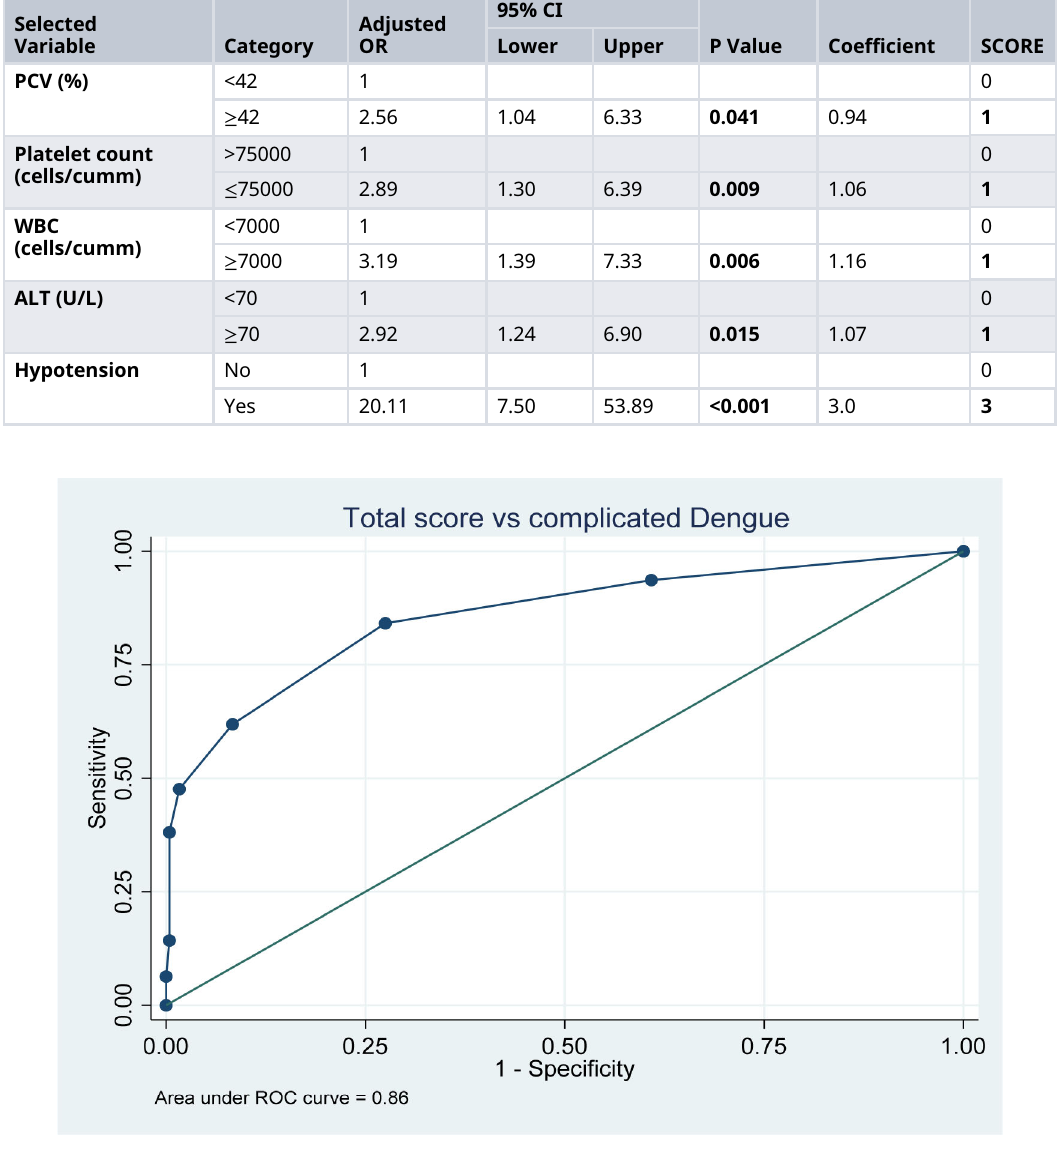
Figure 1. Area under the curve for the calculated predictive scoring.